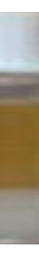
Figure 7. Sample collection.